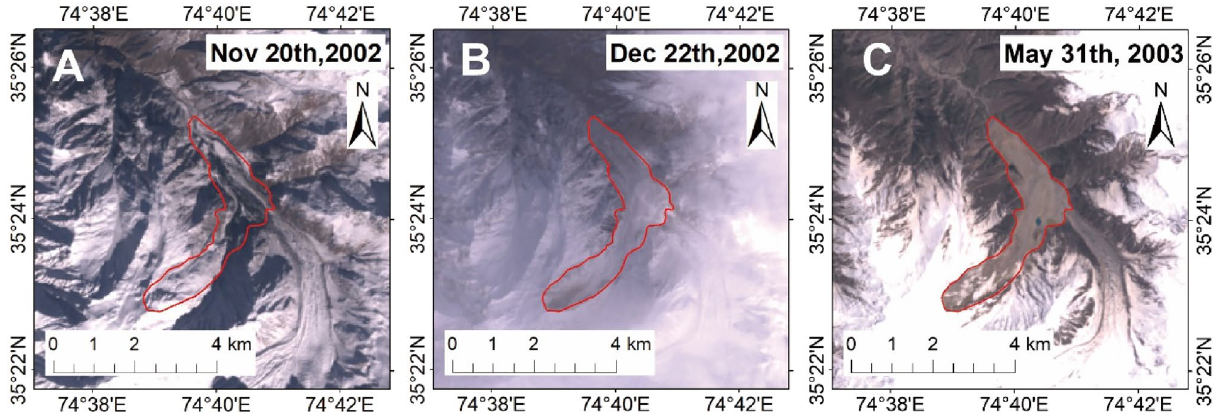
Figure 3. Comparison of landslides before and after being covered by snow. ( A ) is the scene before the landslide failed, ( B ) is the scene after the landslide failed with snow cover, (C) is the scene after the landslide failed without snow cover (Figures created using Arcgis10.2 https ://www.esri.com/en-us/arcgi s/produ cts/arcgi s-deskt